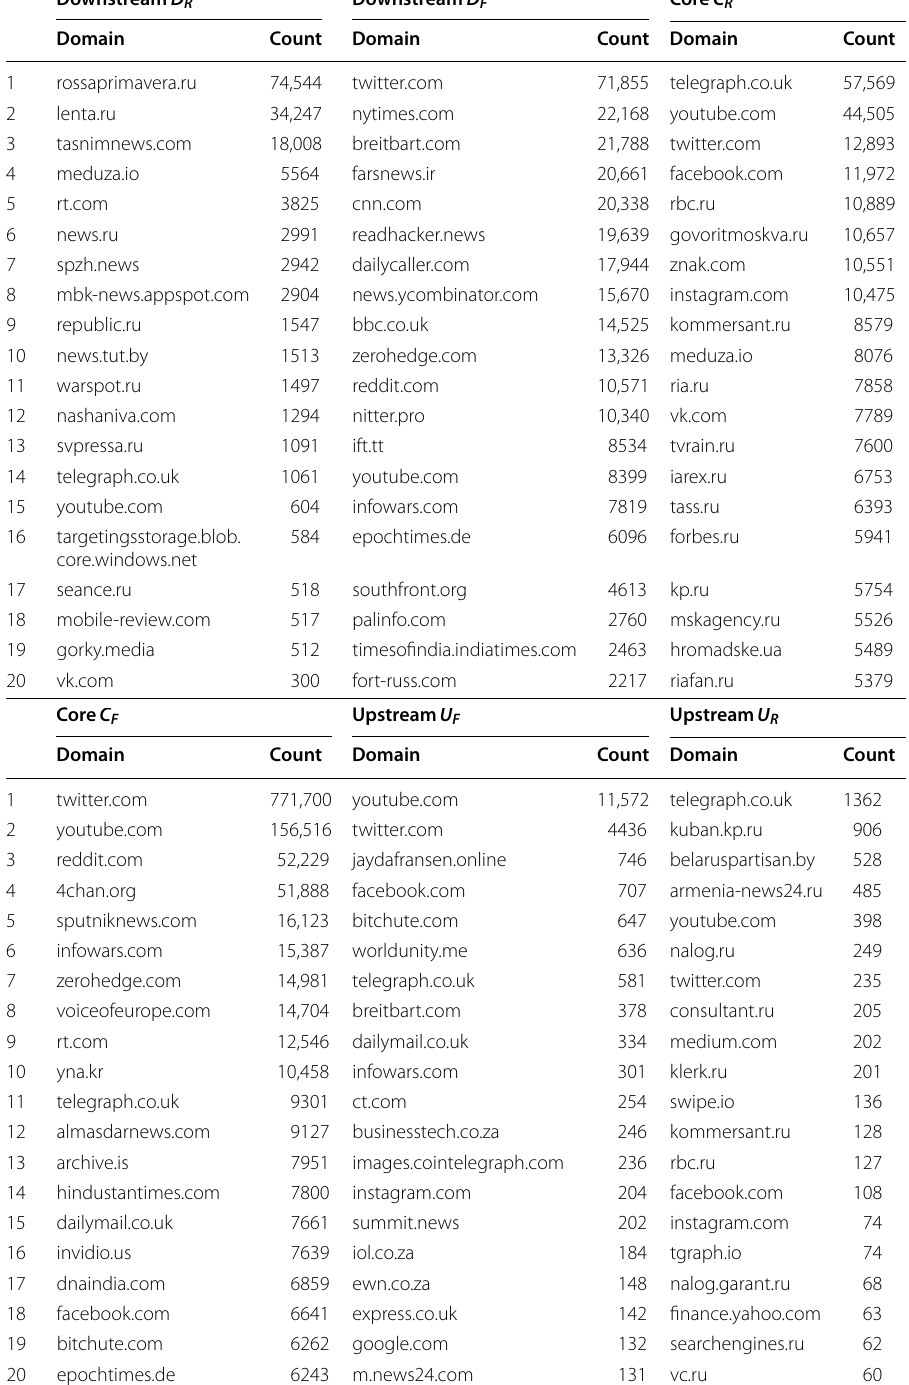
Table 7 Top URL domains shared in the main communities of the network G 2 (July. 2019 to Feb. 2020, Fig.